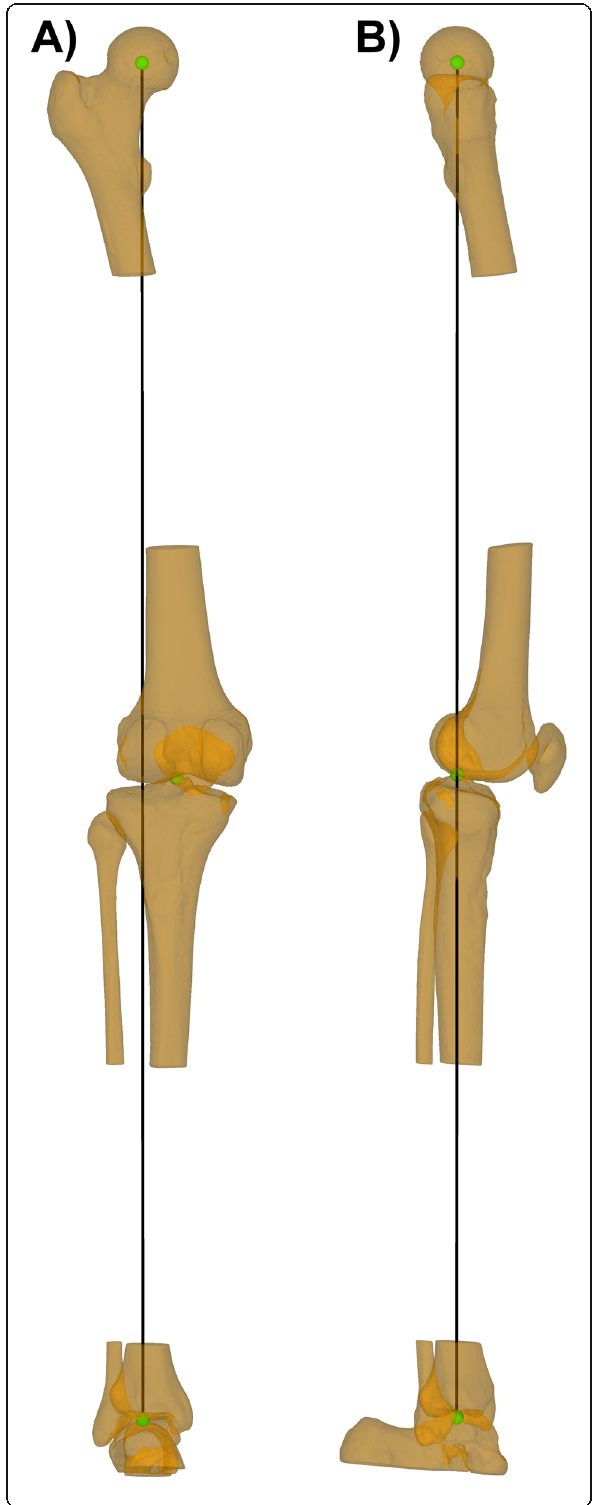
Fig. 1 Alignment of the bone models. In green the hip-, knee-, and ankle-center. In black the axis connecting the hip- and ankle-center. a The bone model is oriented in an antero-posterior (AP) view. b The bone model is internally rotated by 90° to obtain a lateral view. The knee was controlled for full extension in a way that the plumb line from the hip- to the ankle-center passes exactly through the